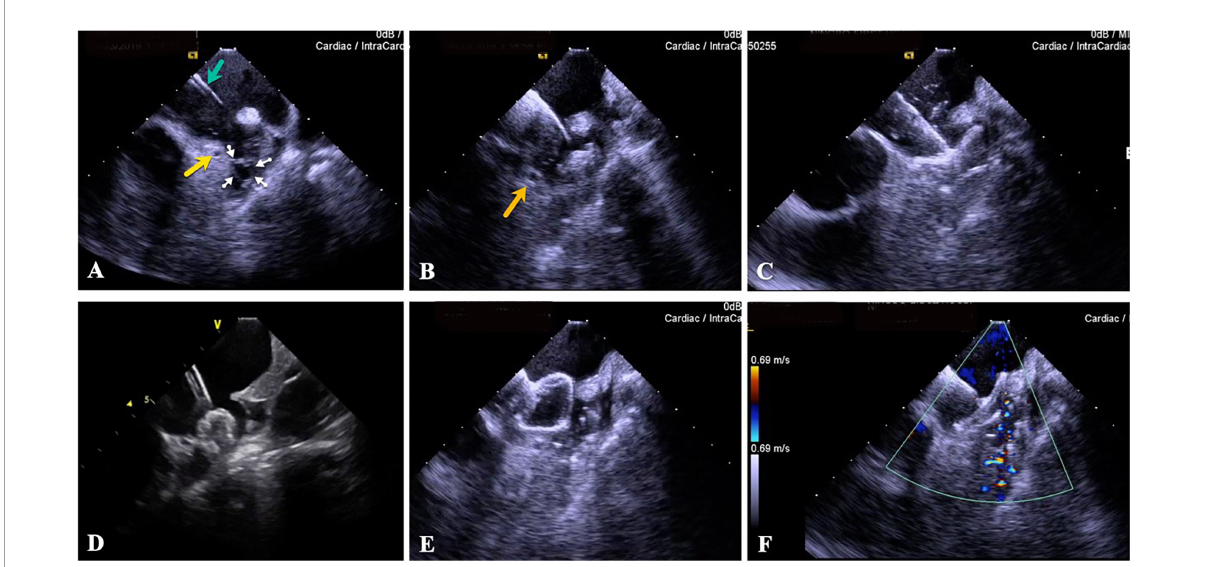
FIGURE11 Process of ICE-guided LAAC. (A) Send the delivery sheath to the ostium of LAA (green arrow), and the pigtail catheter to the inside of LAA (small white arrow), and note the position of the LCX (yellow arrow). (B) Expand the closure device fixation disk, and note that it should be medial to the LCX (orange arrow). (C) Expand the closure disk. (D) Slightly withdraw the closure device (disk). (E) Pull test. (F) There is no residual shunt at the edge of the closure device as assessed by color Doppler flow monitoring at the end of closure. ICE, intracardiac echocardiography; LAA, left atrial appendage; LCX, left circumflex